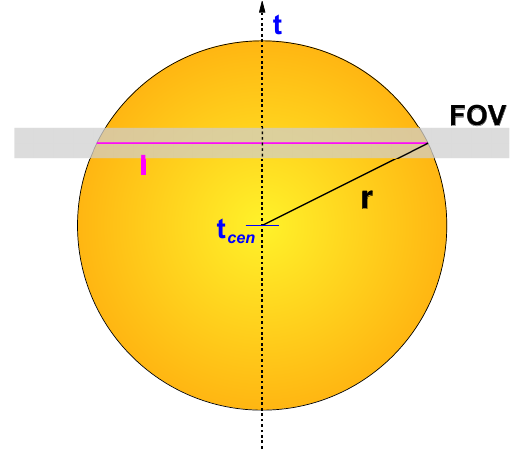
Fig. 4. Sketch for deriving the intensity function of a scan over the solar